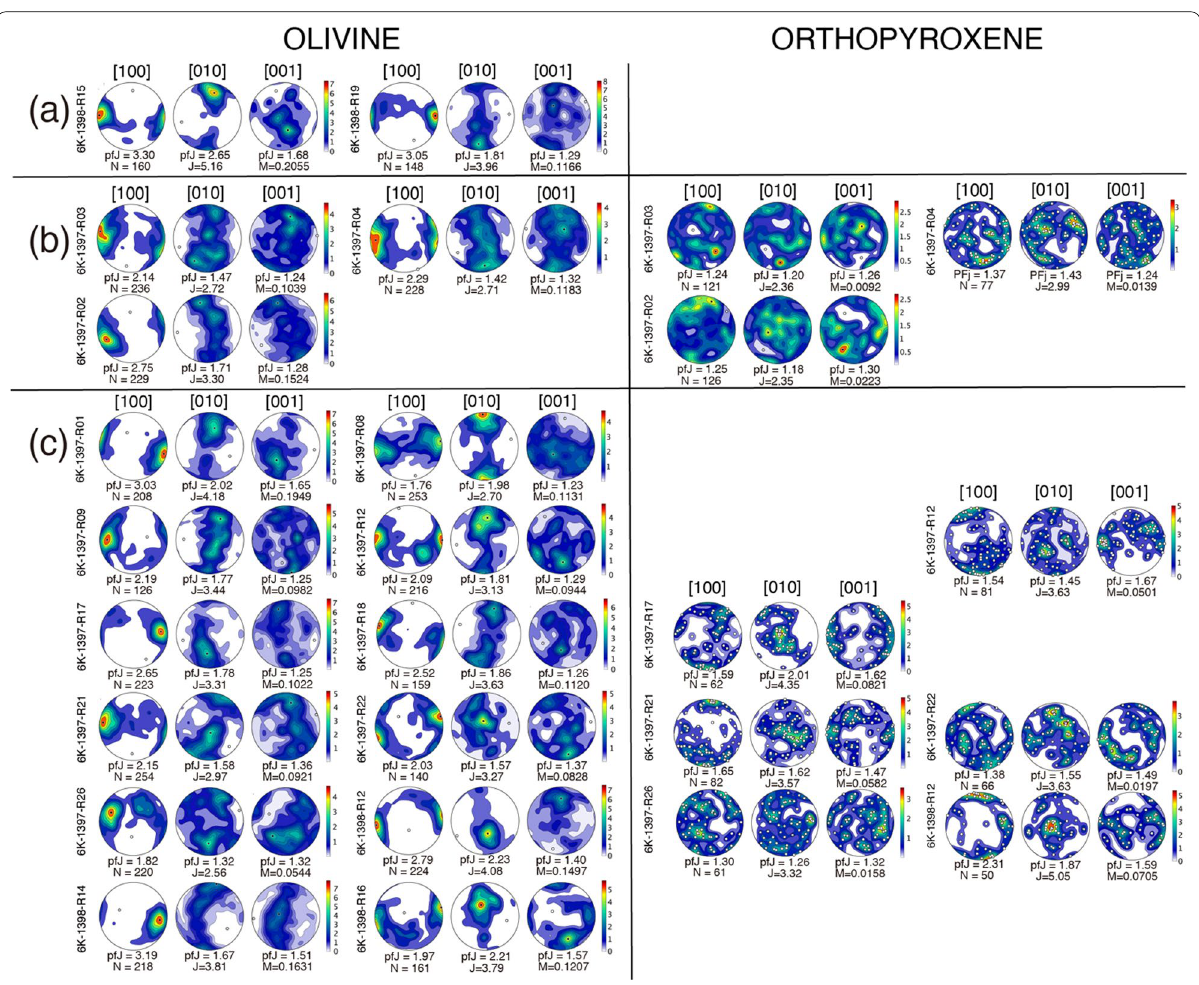
Fig. 6 Olivine and orthopyroxene crystal‑fabric data for peridotites from the 139°E Ridge plotted on equal‑area, lower‑hemisphere projections. Contours are in multiples of uniform distribution. Half widths are 10°. One measurement per grain. In orthopyroxene CPOs comprising fewer than 100 grains, individual grains are shown as a white circle, whereas those less than 50 grains are excluded as they are too small numbers to present CPOs. N is the number of grains measured. J is the J ‑index. M is the M ‑index. pfJ is pfJ ‑index. a Coarse‑grained texture. b Fine‑grained texture. c Heterogeneous textured